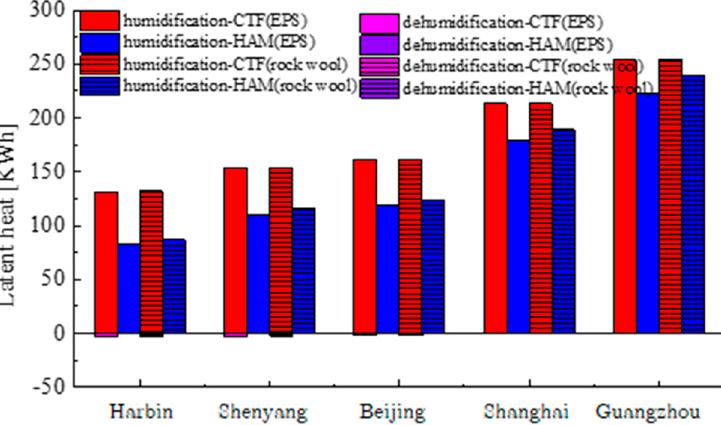
Figure 8. Annual latent heat of a humidistat in the 101 room.